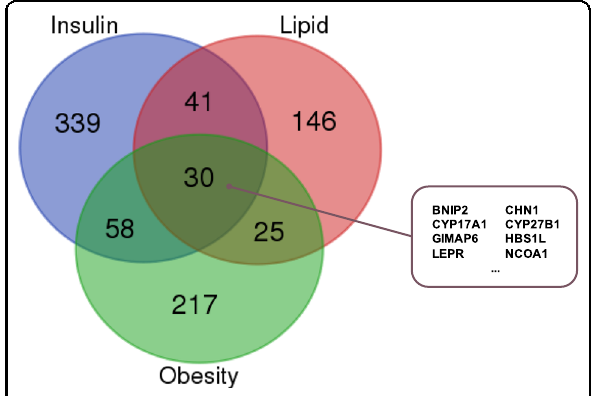
Fig. 2 Genes that showed statistically signi fi cant phenotype changes after KO from IMPC (based on Release